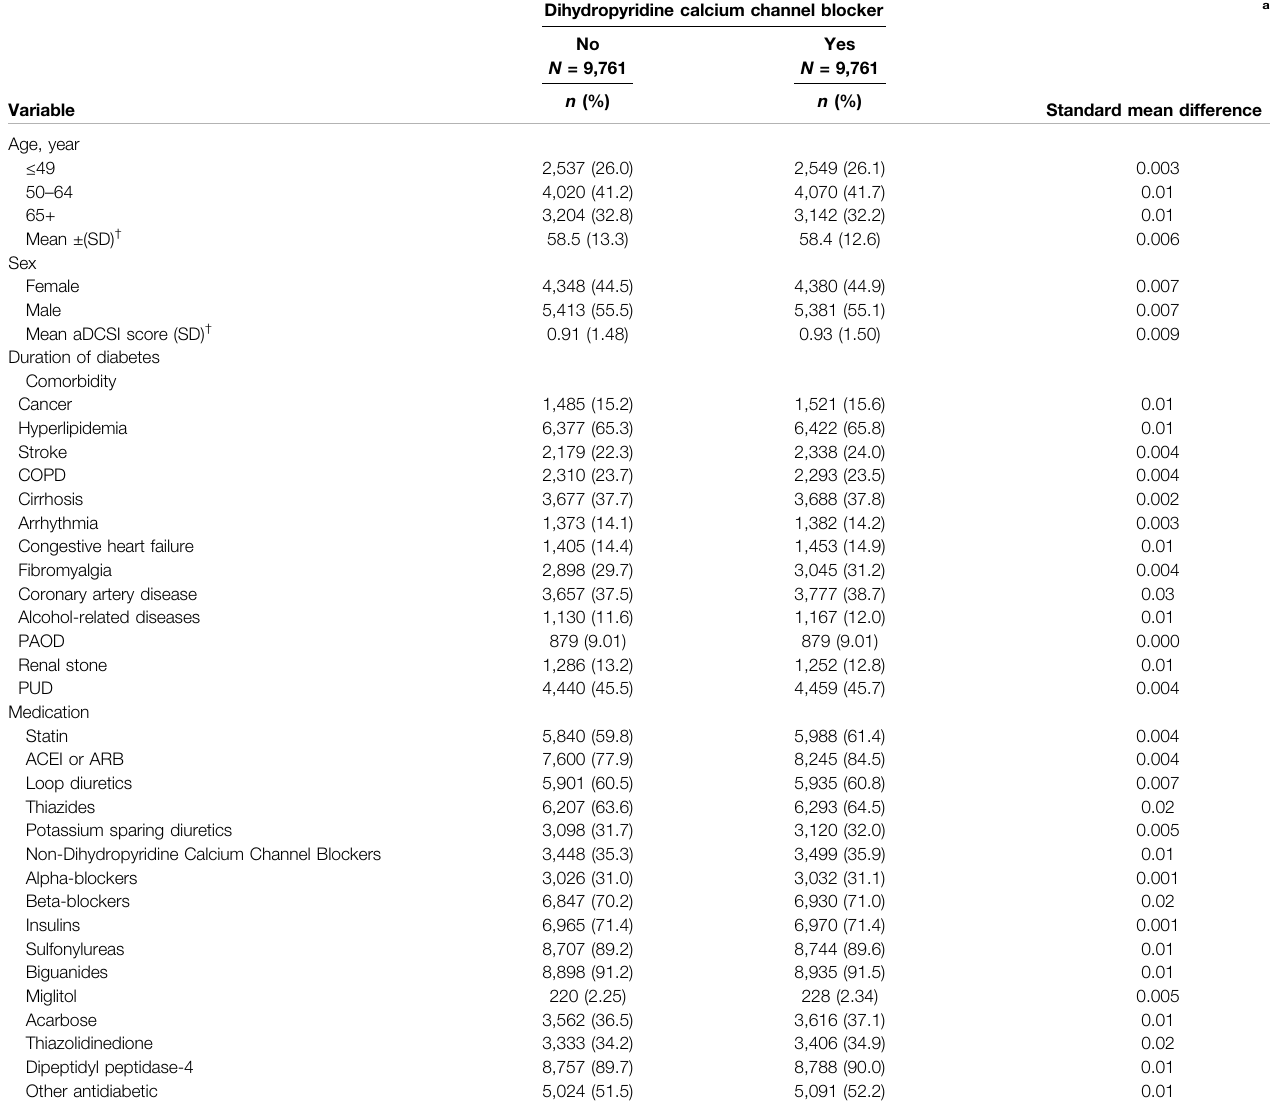
TABLE1| Demographiccharacteristicsandcomorbiditiesinthepropensity-score-matchedcohortswithandwithoutdihydropyridineCalciumChannelBlockerusedamong diabetes mellitus patients with chronic kidney disease.